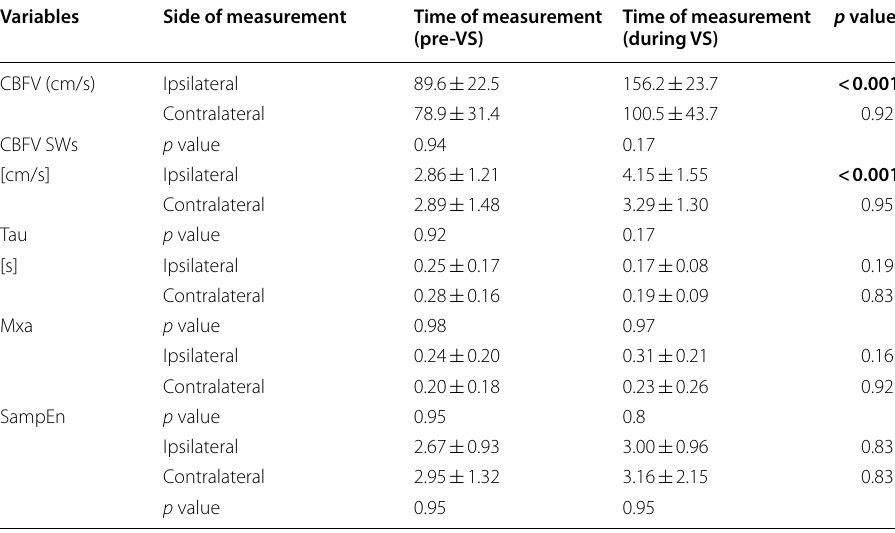
Table 2 Temporal and spatial differences of measured variables across the overall study population Variables